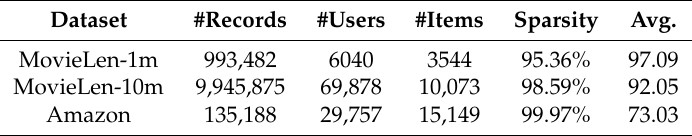
Table 1. Statistics of the evaluation